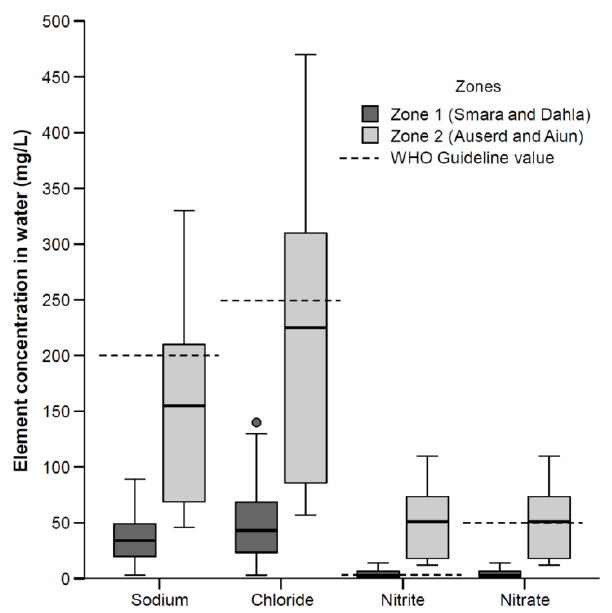
Figure 2. Elements in distributed public drinking water in the Saharawi refugee camps exceeding the WHO guideline values for drinking water. The dotted line the guideline value for the respective elements.